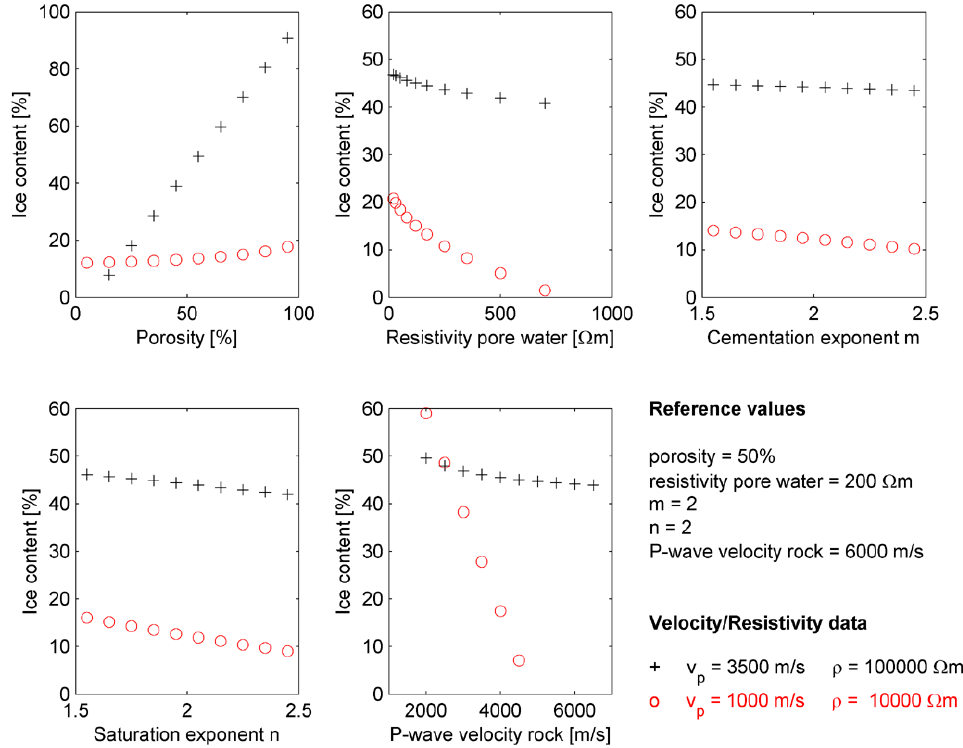
Fig. 4. Sensitivity of ice content estimates to uncertainties in the free Archie parameter and material properties, which have to be prescribed. The sensitivity is shown for the two data pairs of Fig. 3. Each parameter is varied individually while reference values are used for the